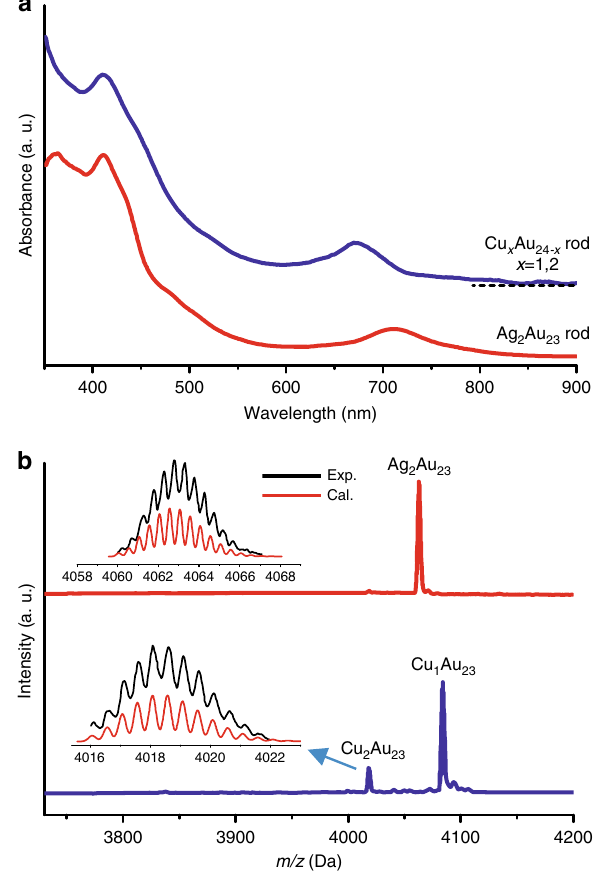
Fig. 6 UV – Vis and ESI – TOF – MS spectra of the secondary shuttling products. a UV – Vis spectra of [Cu x Au 25 − x (PPh 3 ) 10 (PET) 5 Cl 2 ] 2+ ( x = 1,2; blue line) and [Ag 2 Au 23 (PPh 3 ) 10 (PET) 5 Cl 2 ] 2+ (red line), and; b Positive mode ESI-MS spectra of [Cu x Au 25 − x (PPh 3 ) 10 (PET) 5 Cl 2 ] 2+ ( x = 1,2; blue